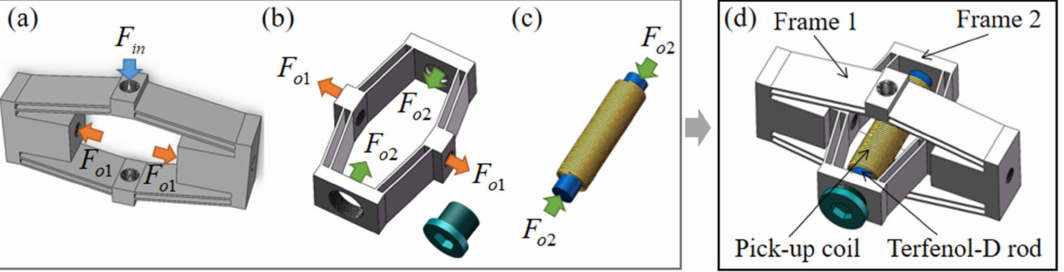
Figure 1. Proposed double-stage rhombus magnetostrictive vibration energy harvesting device.